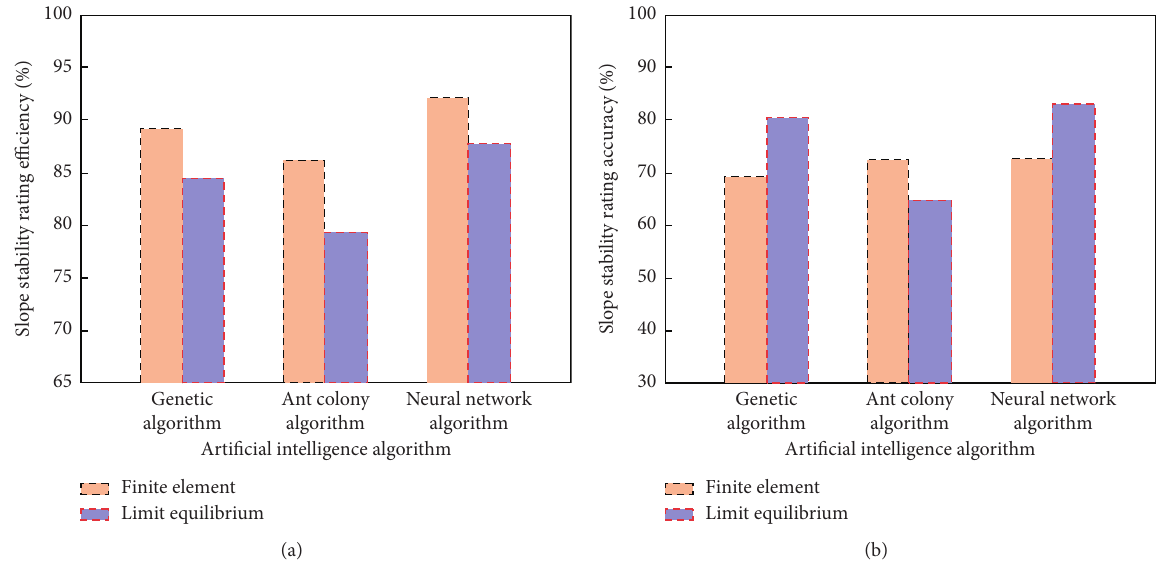
Figure 4: Slope stability rating efficiency (a) and accuracy (b) of three typical artificial intelligence algorithms with finite element and limit equilibrium